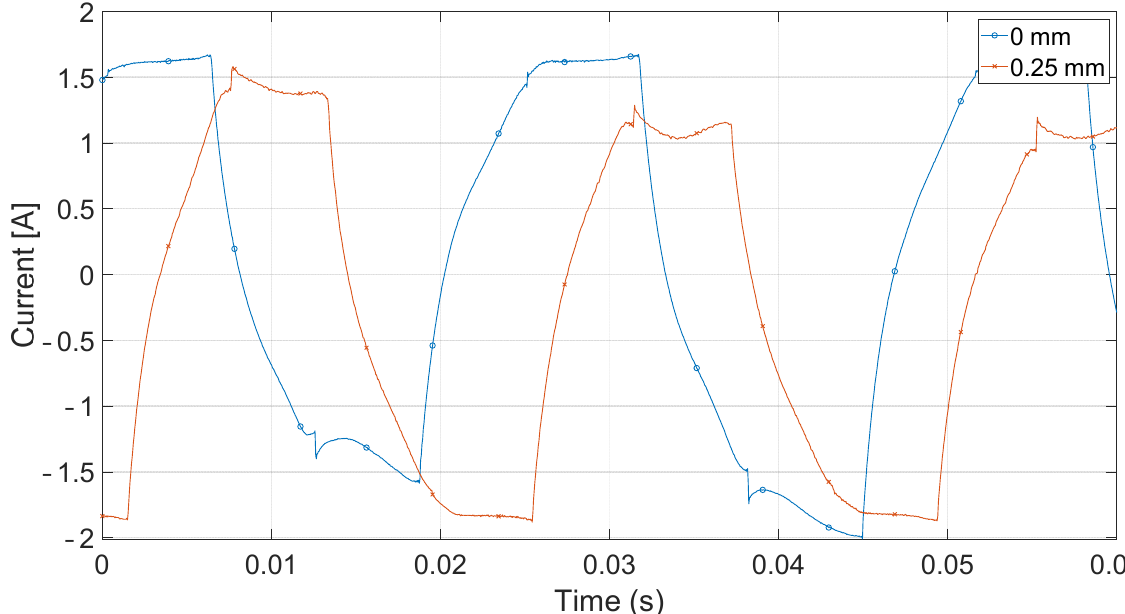
Figure 5. Phase current measured on test bench.